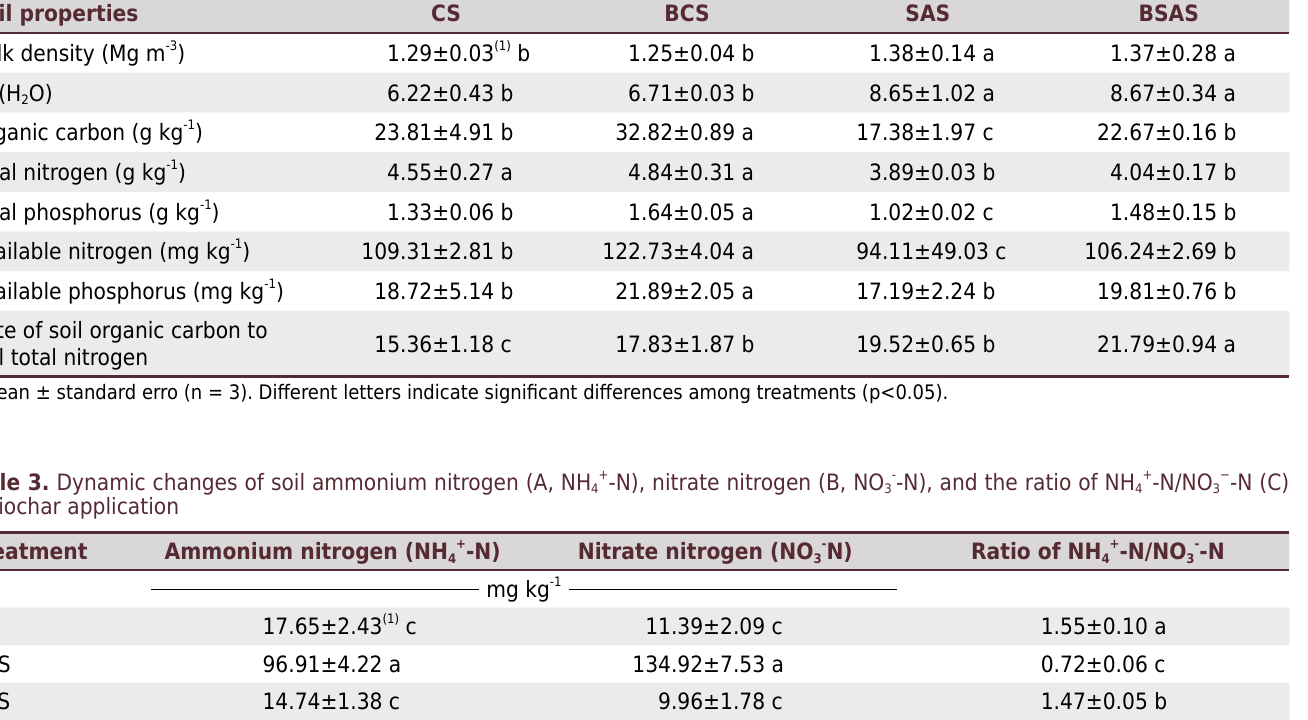
Table 2. Physical and chemical properties in the soil tested Soil properties